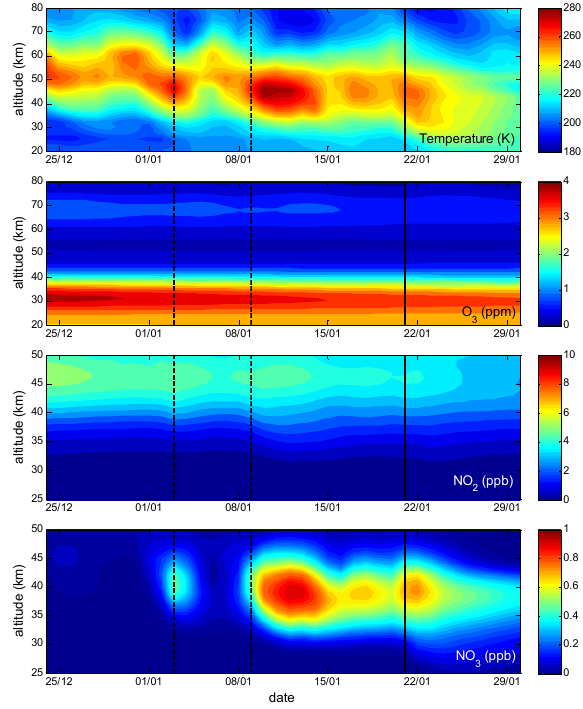
Figure 5 Changes in the middle atmosphere composition during January 2006 SSW as simulated by the SIC model forced by MLS temperature data (shown in the upper panel).